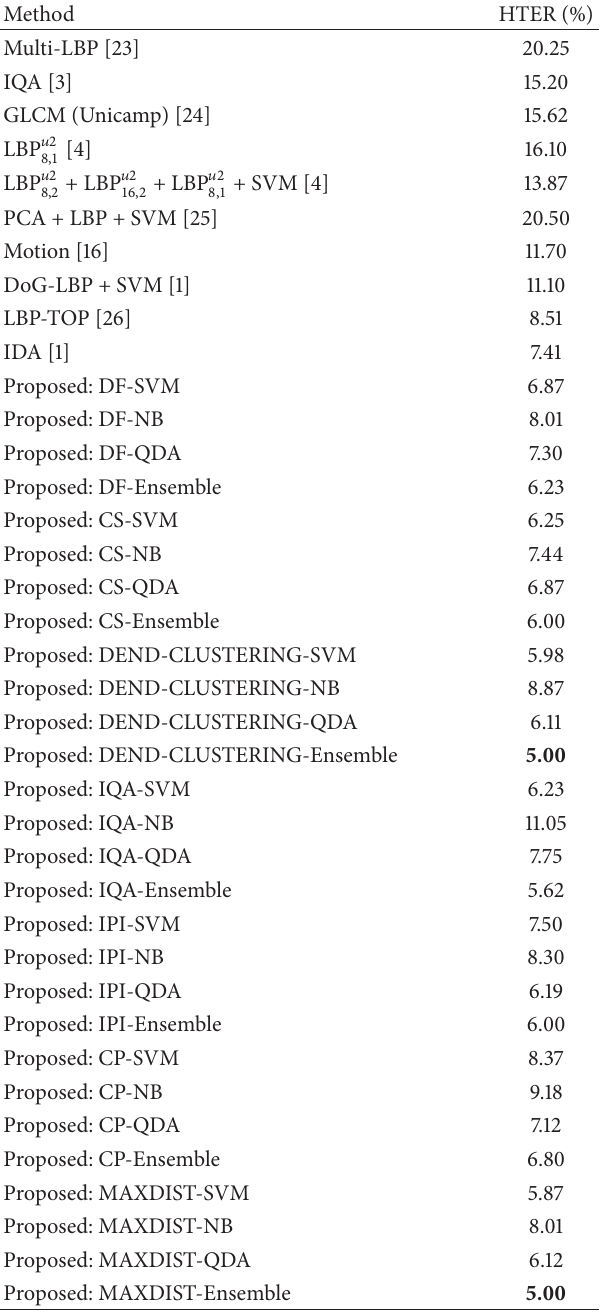
Table 3: Comparison of the proposed method (with SVM, QDA, Naive-Bayes (NB), and Ensemble based classifiers) on REPLAY- ATTACK database with existing